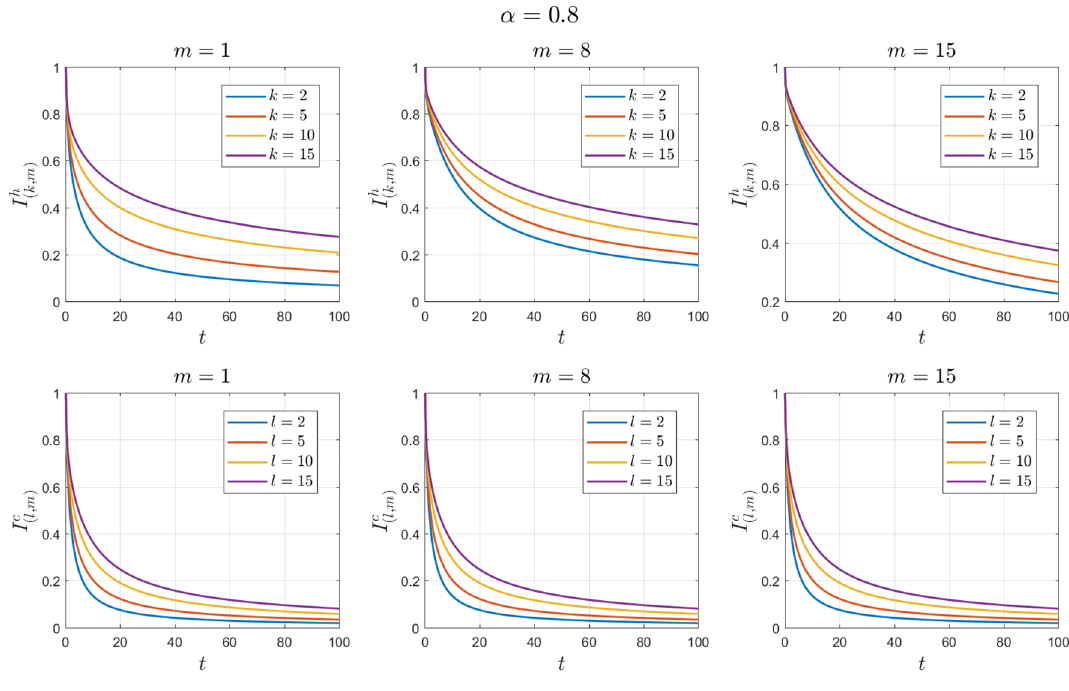
= ( 0 ) , I h ( 0 ) , S c ( 0 ) , I c ( 0 ) S h ( k , m ) ( k , m ) ( l , m ) ( l , m ) (cid:31) (cid:30)